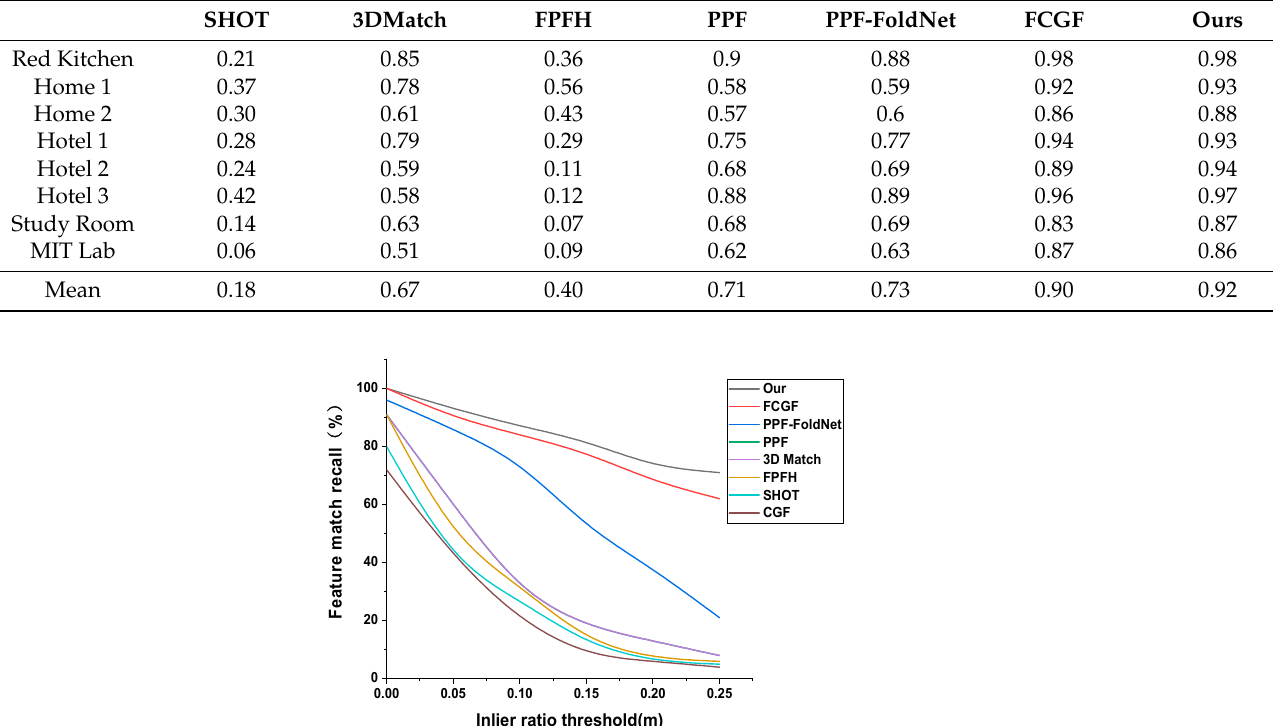
Table 1. Comparison of feature matching recall rates between our model and other advanced models.